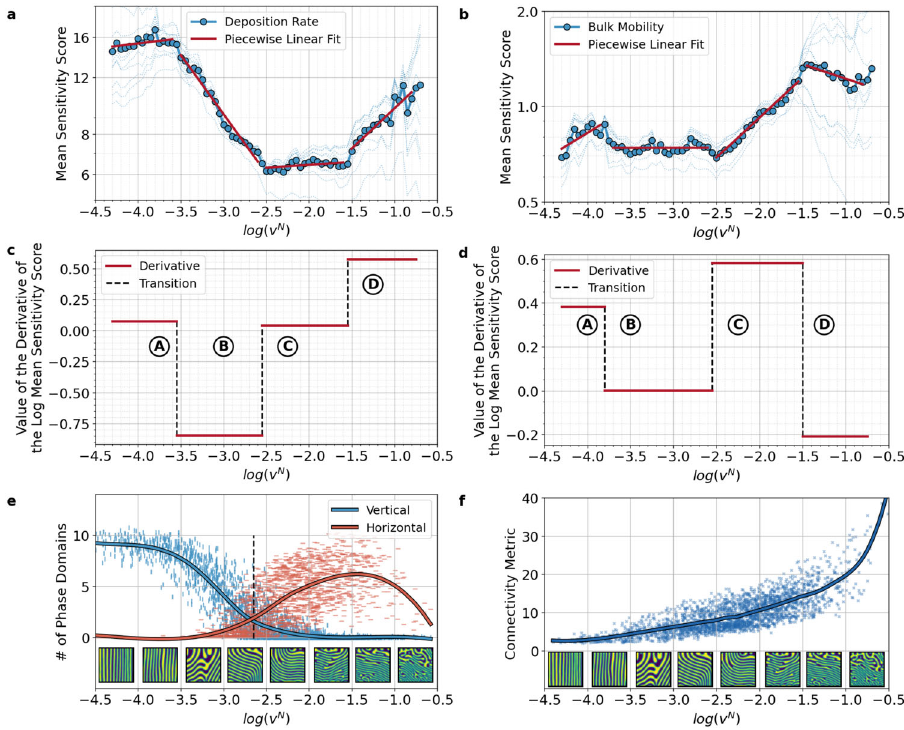
Fig. 5 Identifying microstructural topological transitions for the physical vapor deposition of thin fi lms. a Sensitivity score for predicting the deposition rate ( ∣ v ∣ ) as a function of the normalized deposition rate. b Sensitivity score for predicting the bulk mobility ( M Bulk ) as a function of the normalized deposition rate. c Variation (derivative) of the sensitivity score for the deposition rate as a function of the normalized deposition rate. d Variation (derivative) of the sensitivity score for predicting the bulk mobility as a function of the normalized deposition rate. e Number of horizontal and vertical phase domains as a function of the normalized deposition rate. f Topology connectivity (de fi ned as the number of irregular elements of morphologies e.g . , kinks, terminated subdomains, etc.) as a function of the normalized deposition rate. Thin blue lines in ( a ) and ( b ) illustrates particular runs of our procedure and indicate the variability around the averaged sensitivity